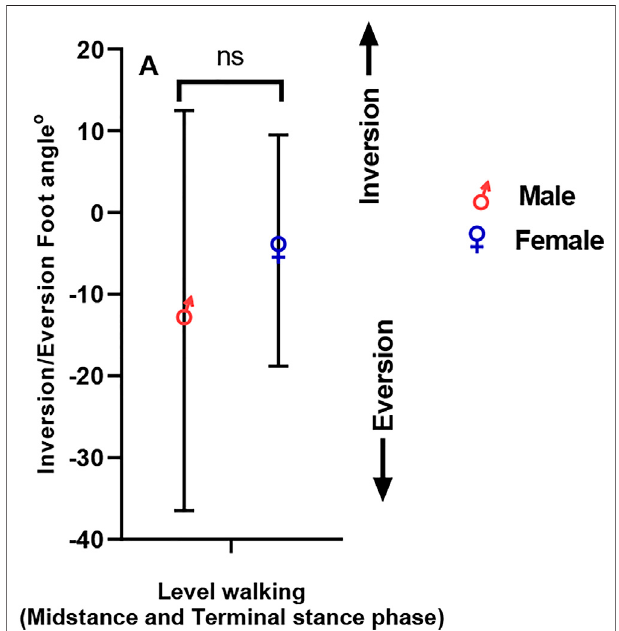
FIGURE 3 | Inversion/eversion foot angle in male and female